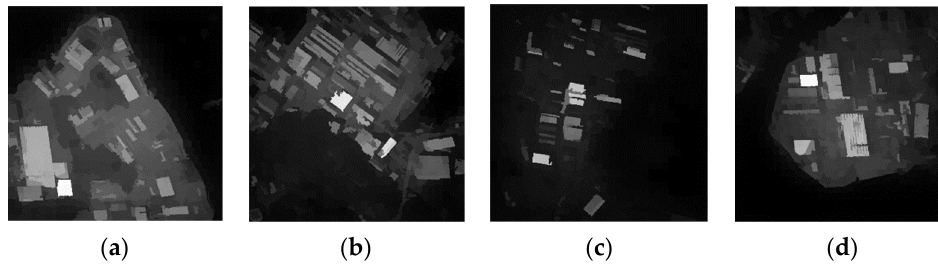
Figure 10. Saliency maps after fusion. ( a ) Image I, ( b ) Image II, ( c ) Image III, ( d ) Image IV.